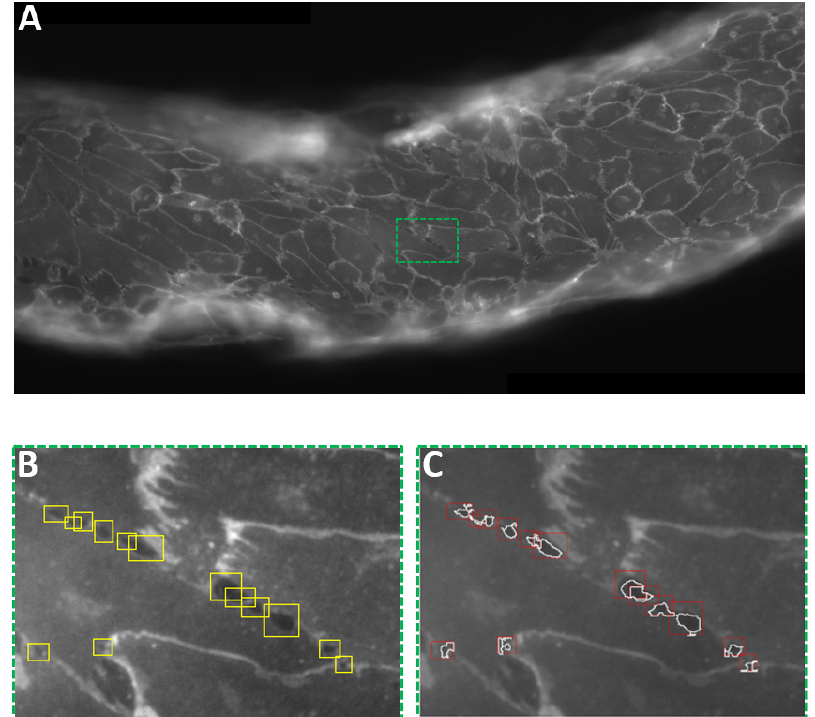
Figure 5. Interendothelial gap analysis. ( A ) Portion of the stitched confocal fluorescence image of the vascular channel. ( B ) Cropped image from ( A ). Interendothelial gaps opened upon cavitation are manually selected as rectangular ROIs in ImageJ. A list of ROIs is thus obtained and processed as described in Section 2.9. ( C ) Same cropped image as in ( B ), after processing. The code operates directly on the ROIs selected in the TIF file, identifying the gap contained in each rectangular ROI and its